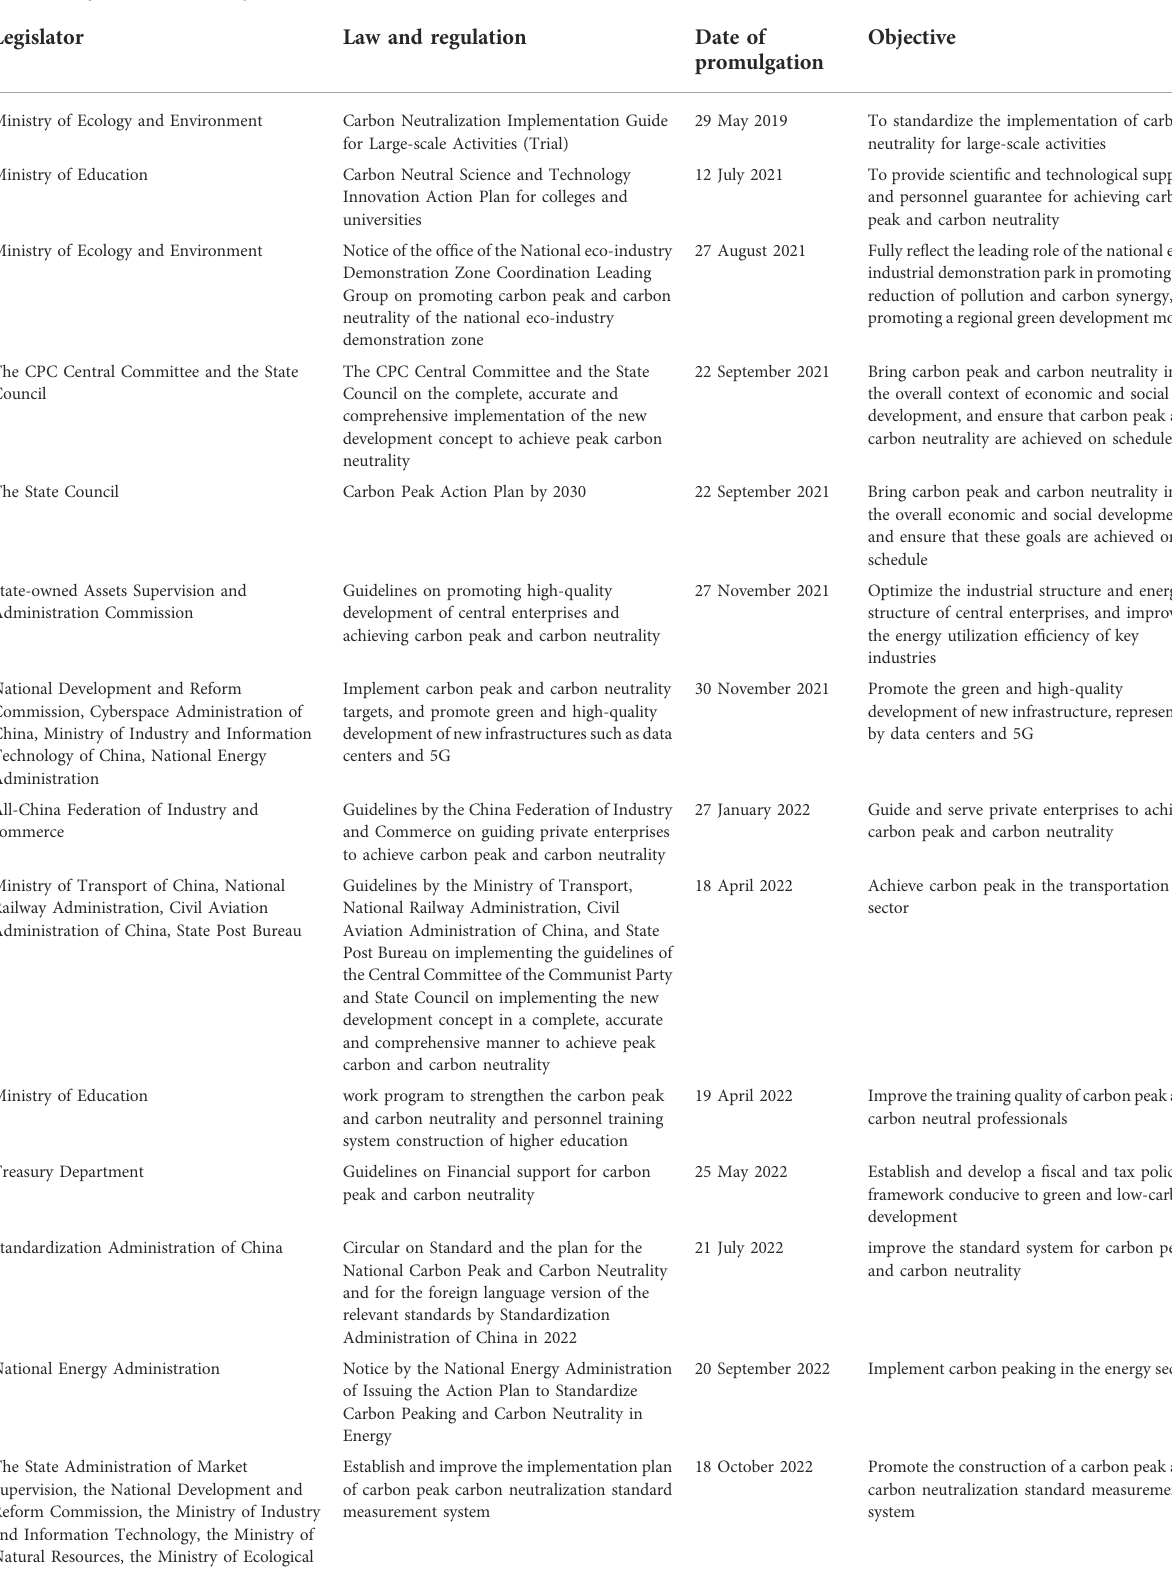
TABLE 2 Objectives of central policies and